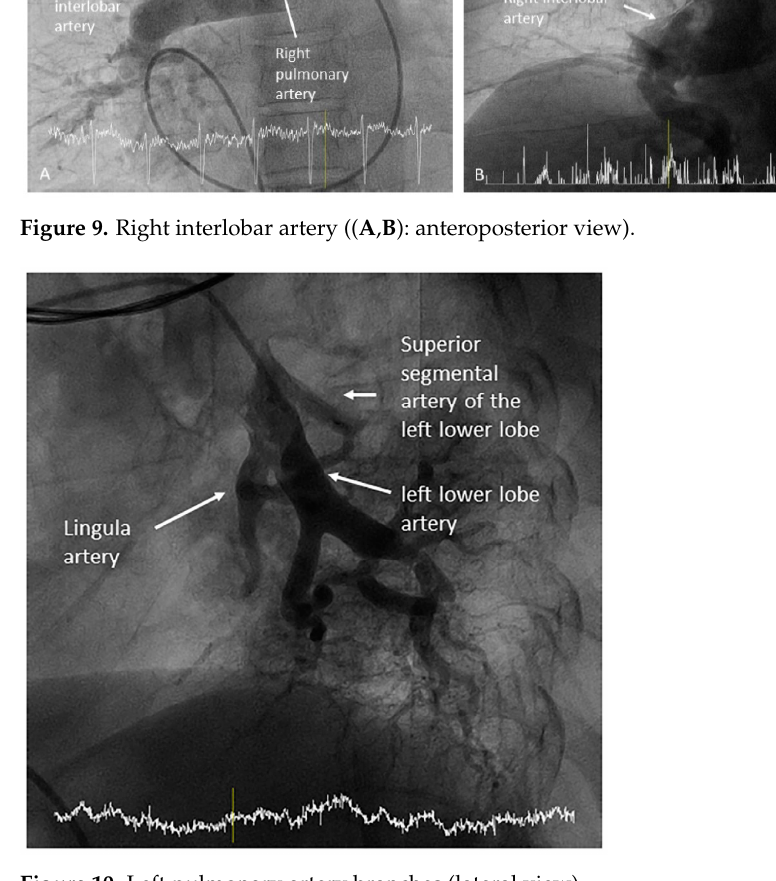
Figure 10. Left pulmonary artery branches (lateral view).